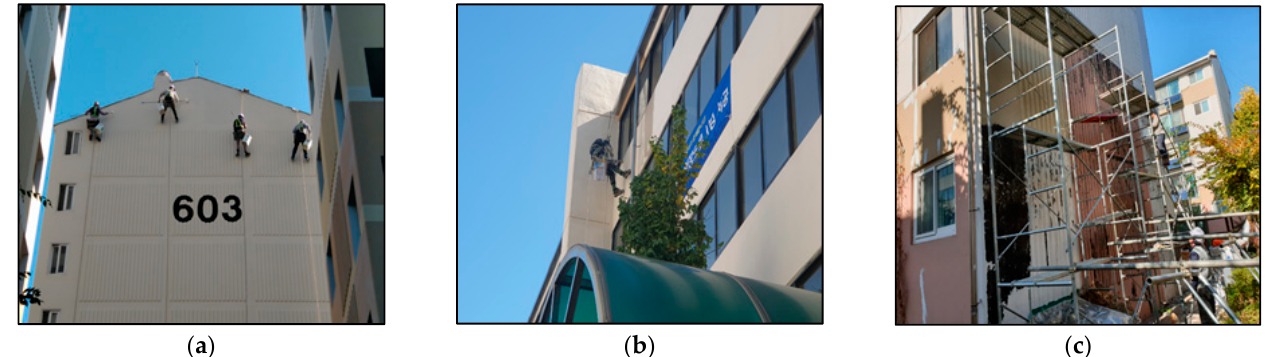
Figure 8. Photocatalytic materials applied on the real buildings in the field assessment. ( a ) Building A, photocatalyst coating; ( b ) Building B, photocatalyst paint; ( c ) Building C, photocatalyst shotcrete.